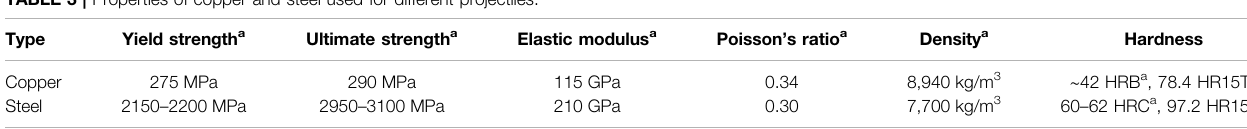
TABLE 3 | Properties of copper and steel used for different